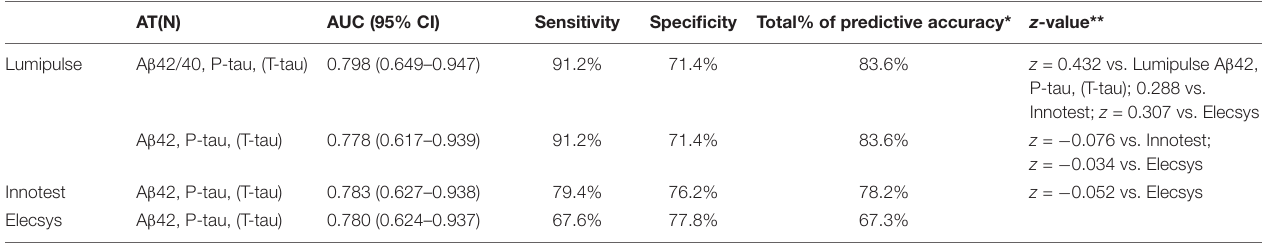
TABLE 3 | Diagnostic accuracy of the AT(N) classification for each method.